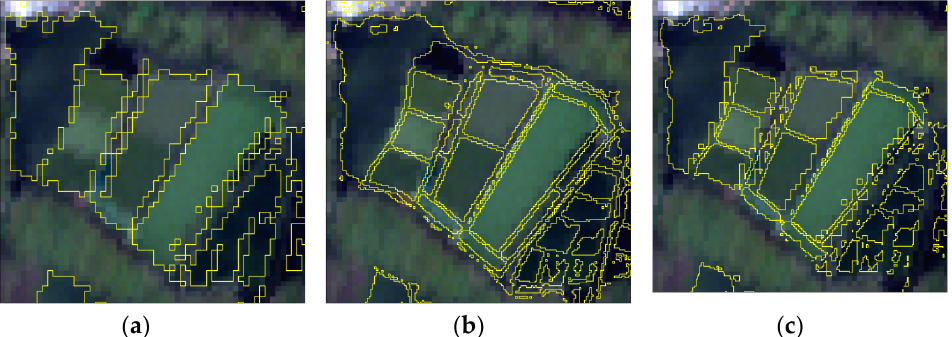
Figure 4. Example of water body extraction, ( a ) hyperspectral extraction of water surfaces; ( b ) multi-spectral extraction of water surfaces; ( c ) body of water after superposition.